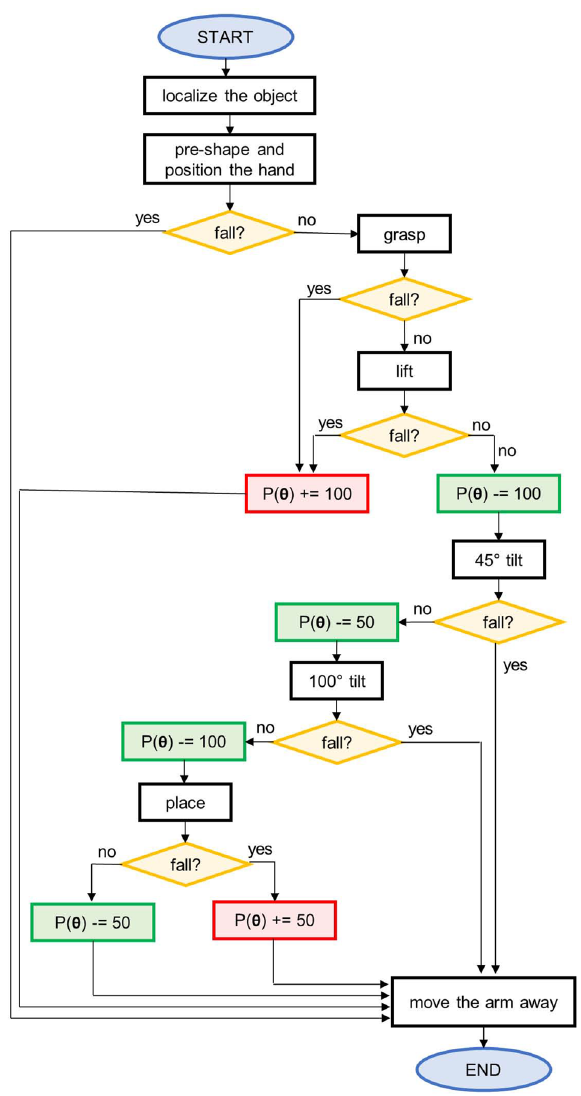
Figure 1. Block diagram of the task, here detailed step by step: (i) localize the object , the object’s position, radius and height are assessed from RGBD data; (ii) pre-shape and position the hand , the thumb is opposed and the hand placed in the desired grasp point. (iii) grasp , the joints of the hand are moved according to the parameters in θ ; (iv) lift , the hand is raised; (v) 45° tilt, the arm is brought to a pre-defined configuration, then the wrist is rotated by 45°; (vi) 100° tilt , the wrist is rotated to achieve a 100° of the bottle; (vii) place , the arm returns to the configuration in (iv), the hand then moves down and opens to release the object; (viii) move the arm away , the hand is distanced from the